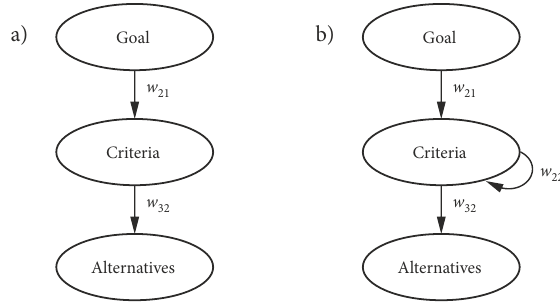
Fig. 3. Hierarchy and network: (a) hierarchy; (b) network (Yüksel, Dağdeviren